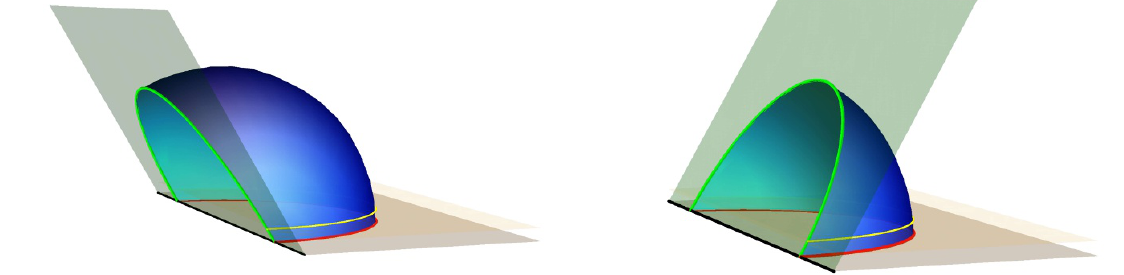
Figure 14 . Minimal surfaces ^ (cid:13) A anchored to the entangling curve corresponding to a half disk A centered on the (cid:13)at boundary. The slope of the green half plane Q is (cid:11) = (cid:25)= 3 in the left panel and (cid:11) = 2 (cid:25)= 3 in the right panel. The yellow half plane has z = " and its intersection with ^ (cid:13) A is the yellow curve. The green curve corresponds to @ ^ (cid:13) Q in